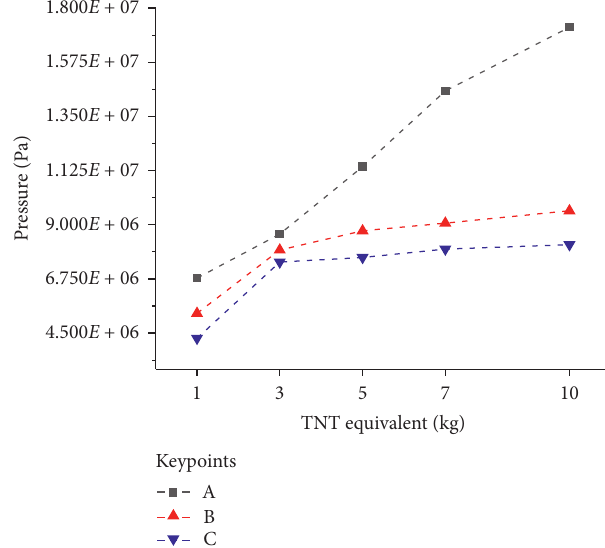
Figure 12: Dynamic response of pipes under different TNT